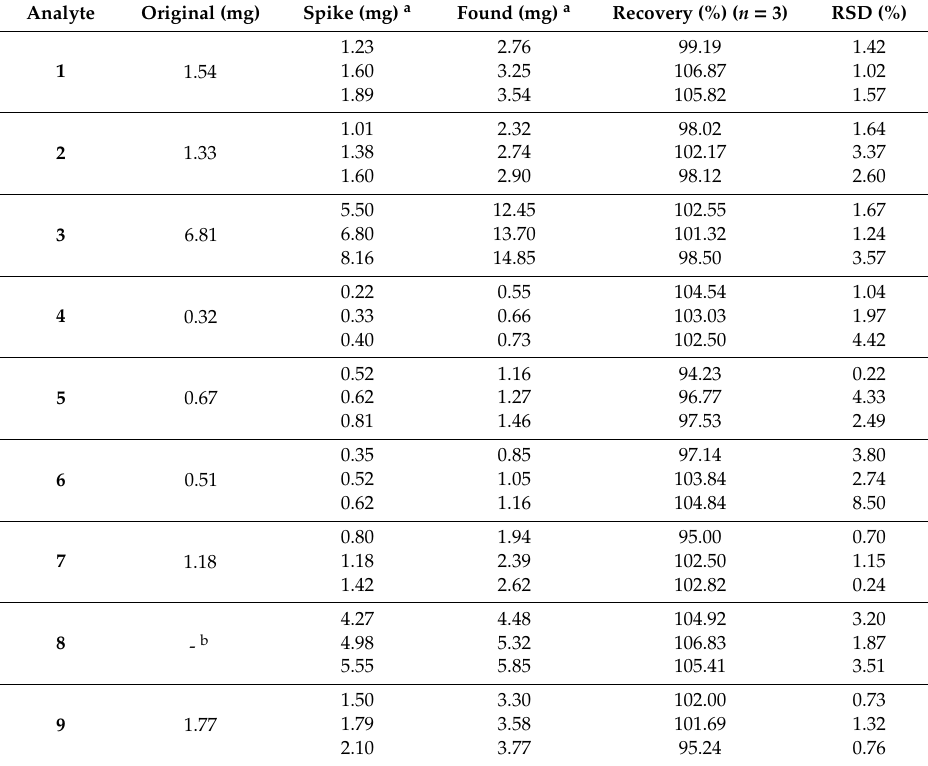
Table 4. Recoveries of the nine triterpenoids in P.